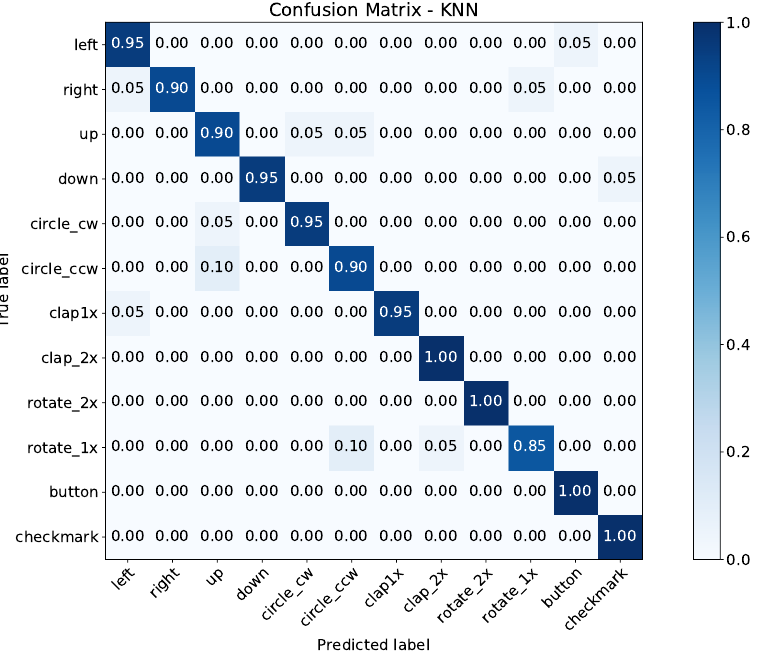
Figure 14. Confusion matrix for the worst performing model representative trained by the watch data set of the watch session. The KNN model achieved an accuracy of 94.6%, while utilizing the medium sized feature